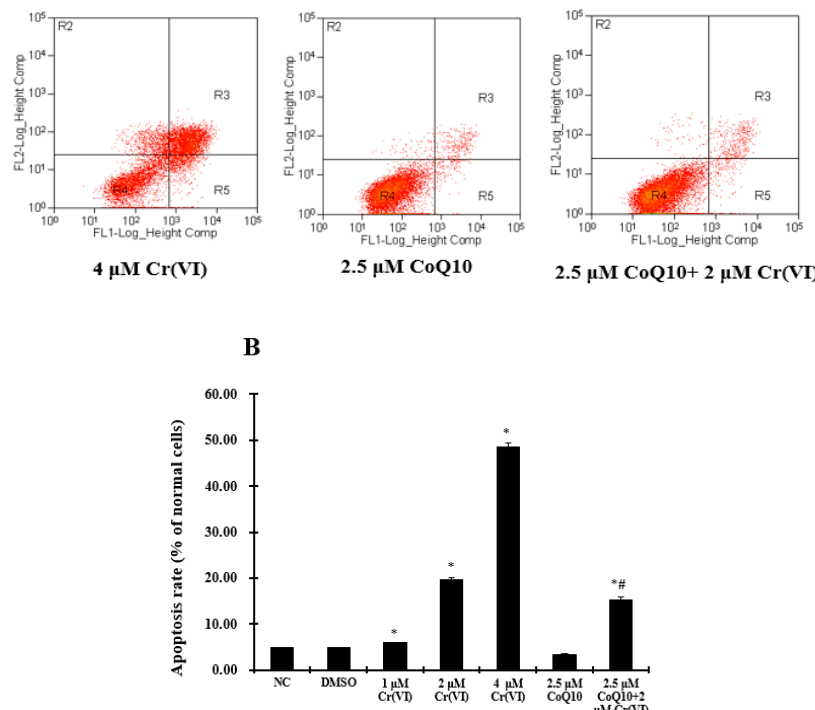
Figure 7. Cr(VI) induces apoptosis in L-02 hepatocytes, and CoQ10 antagonizes apoptosis. ( A ) Cells were stained with Annexin V-FITC/PI and analyzed by flow cytometry. Both early apoptotic and late apoptotic cells were assessed in the cell death determinations. The experiments were repeated three times; ( B ) Quantification of apoptotic cells. Data were obtained from flow cytometry assays and were expressed as mean ± SD ( n = 6). * p < 0.05 compared with the control group; # p < 0.05 compared with the 2 μ M Cr(VI) treatment group.